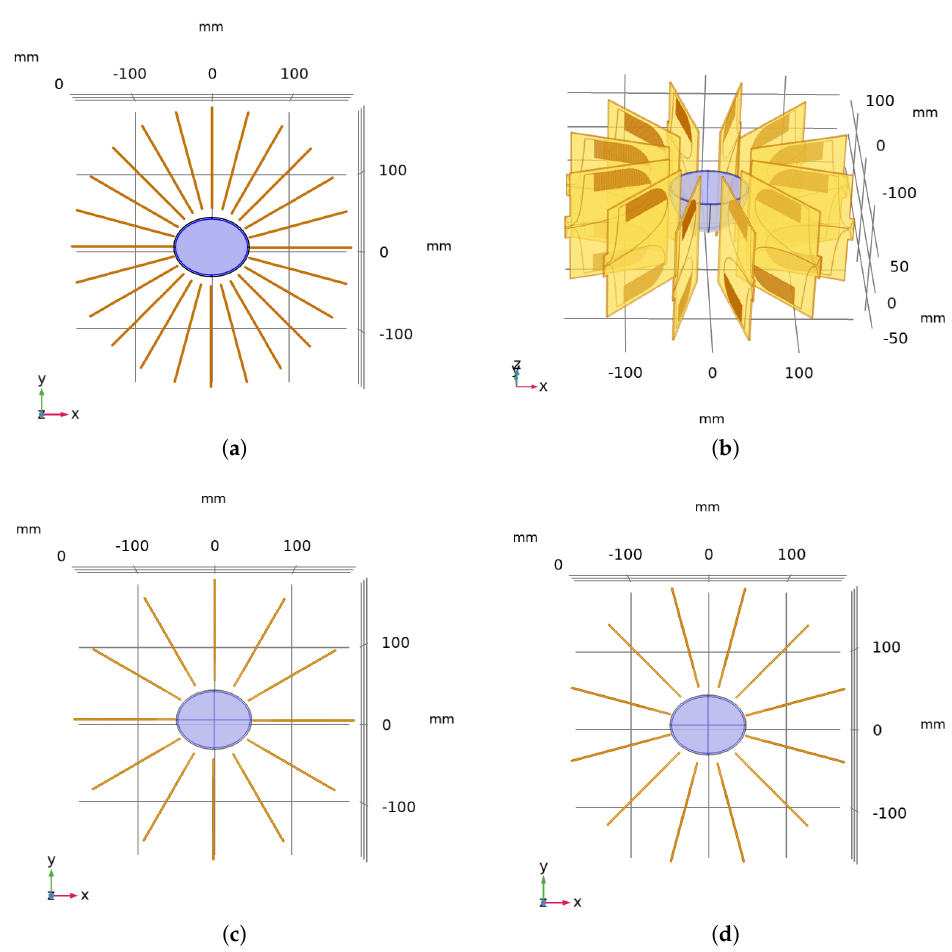
Figure 3. ( a ) Top view of the circular MH applicator with 24 antennas and θ = 0 ◦ . ( b ) Side view of the circular MH applicator with 12 antennas and rotation angle θ = 15 ◦ . ( c , d ) Top views of the circular MH applicator with 12 antennas and θ = 0 ◦ and θ = 15 ◦ ,